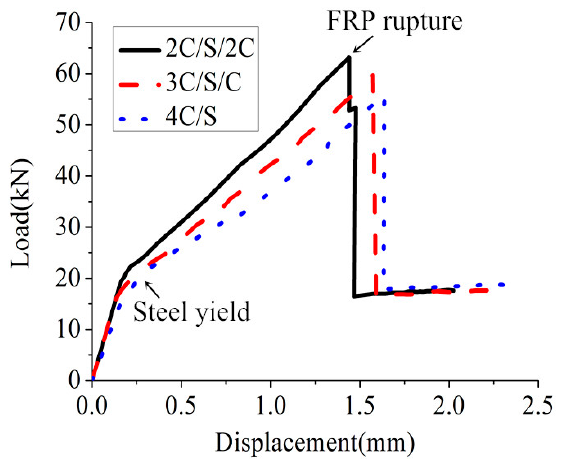
Figure 5. Load-displacement curves of series S specimens.